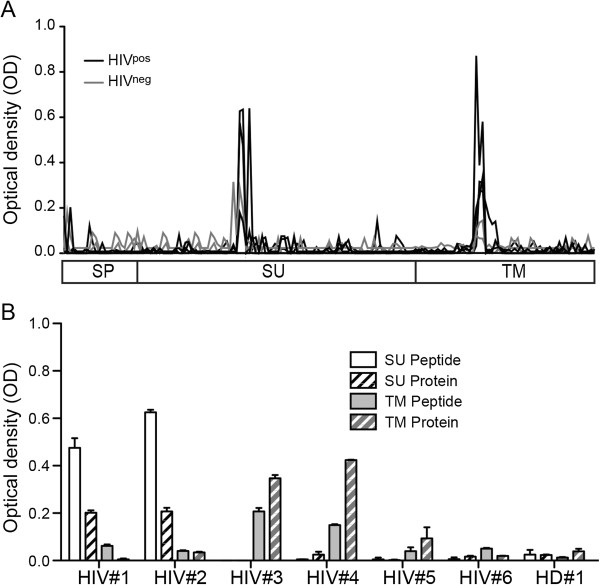
Identification of two linear epitopes on HERV-K (HML-2) Env. (A) 4 sera from chronically HIV-1 infected patients (HIVpos; black) and 2 sera from seronegative low risk healthy donors (HIVneg; grey) were used for antibody epitope identification by ELISA. The 3 sub-units signal peptide (SP), surface-unit protein (SU) and trans-membrane proteins (TM) are represented by 172 redundant 15mers. The lines represent the average of duplicate signals (OD) for each individual. (B) Sera from patients have antibodies reacting only with the SU-peptide (HIV#1 and #2), only with the TM-peptide (HIV#3 and #4), or negative for both epitopes (HIV#5, #6 and HIVneg #1), were used to confirm the signal obtained with the peptide-based ELISA. Plain columns represent the peptides and the hatched columns represent the recombinant protein; SU in white and TM in gray. The ELISA was performed in duplicate, and the error bars represent the SEM.